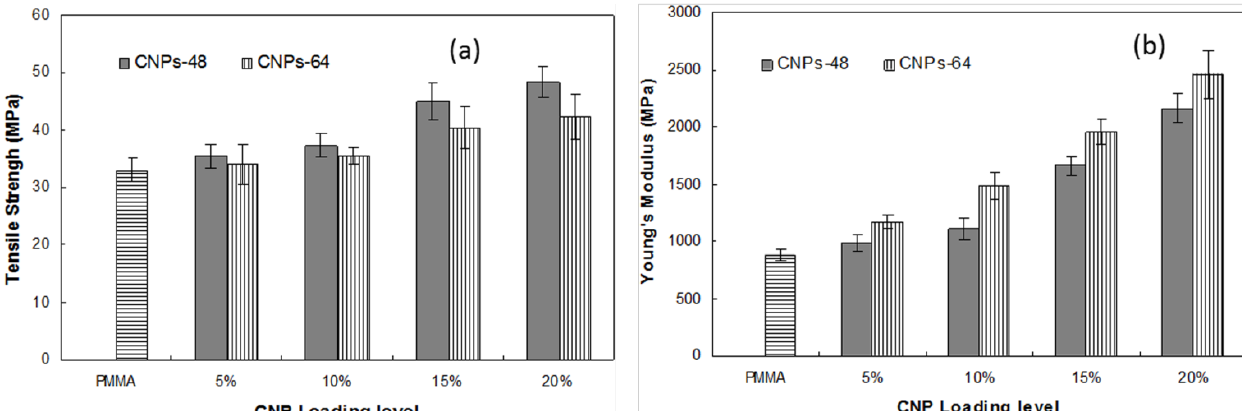
Figure 9. ( a ) Tensile strength and ( b ) Young’s modulus of pure PMMA and CNP/PMMA films at different CNP